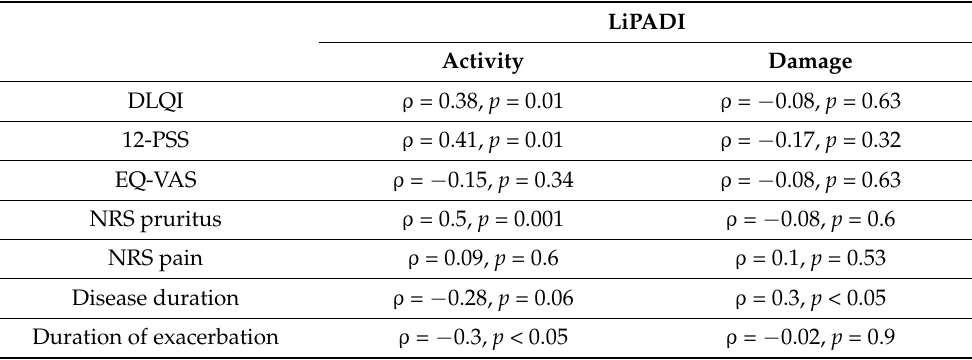
Table 1. Correlations coefficients between the domains of LiPADI (Lichen Planus Activity and Dam- age Index) with other tested variables ( p values according to Spearman rank correlation test) (DLQI— Dermatology Life Quality Index, EQ-VAS—EQ-Visual Analogue Scale EQ-5D, NRS—Numerical Rating Scale, 12-PSS—12-Item Pruritus Severity